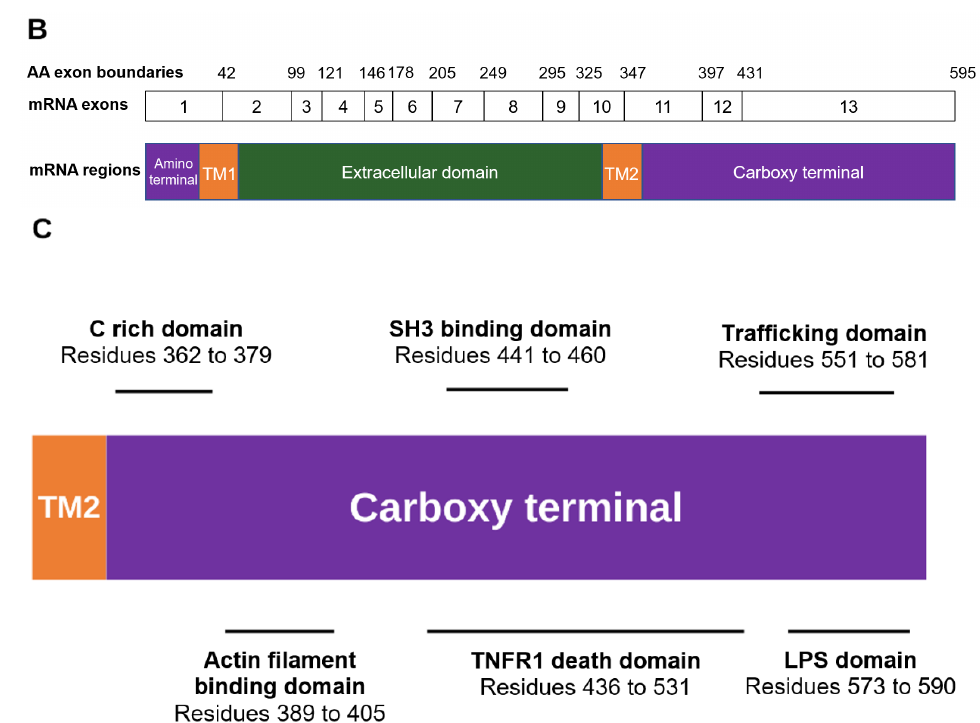
Figure 2. Overview of the regions constituting the P2X7A subunit. ( A ) Ribbon representation of the P2X7A subunit structure. The intracellular amino and carboxy termini are shown in purple, the transmembrane domains (TM1 and TM2) are shown in orange, and the extracellular domain is shown in green. ( B ) The exonic structure of the full-length P2RX7 messenger ribonucleic acid (mRNA) (exons 1 to 13) that encodes the 595 amino acid P2X7A subunit. The amino acid exon boundaries are numbered above the exonic structure (i.e., exon 1 encodes amino acids 1 to 42 of the P2X7R protein, exon 2 encodes amino acids 43 to 99, and so on). The corresponding P2X7A subunit regions that are translated from the mRNA are illustrated below the exonic structure with the colours aligning to the regions shown in ( A ). ( C ) Domains of interest located within the carboxy terminal of the P2X7A subunit including the C rich domain, actin filament binding domain, SH3 binding domain, TNFR1 death domain, trafficking domain, and LPS domain. Structural model produced using PyMOL software version 2.5.2 [23].